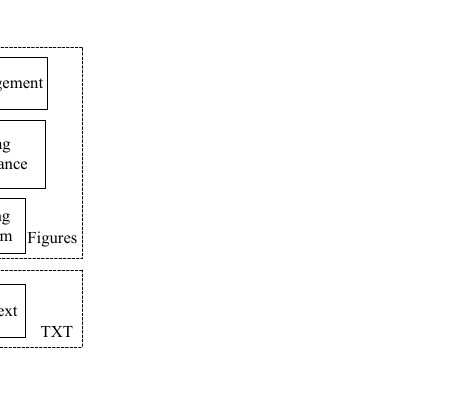
Figure 18. The schematic diagram of how this